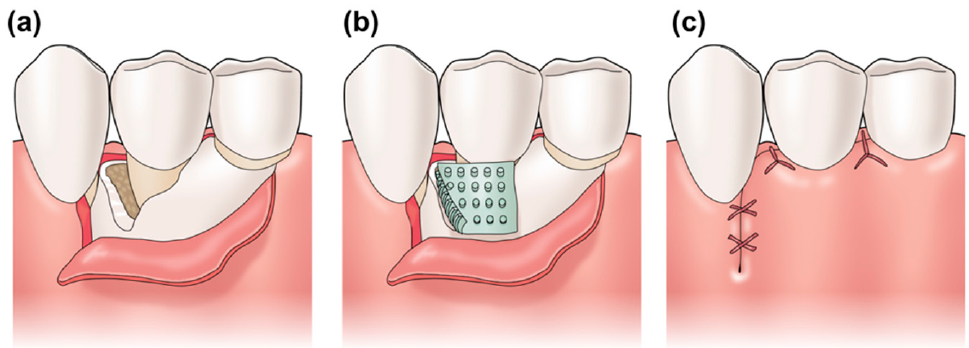
Figure 8. Diagram for clinical application of the patterned PLGA membrane. ( a ) Bone defect caused by periodontal disease. ( b ) Using the micro/nanopatterned PLGA membrane in GTR. ( c ) Suture was performed.